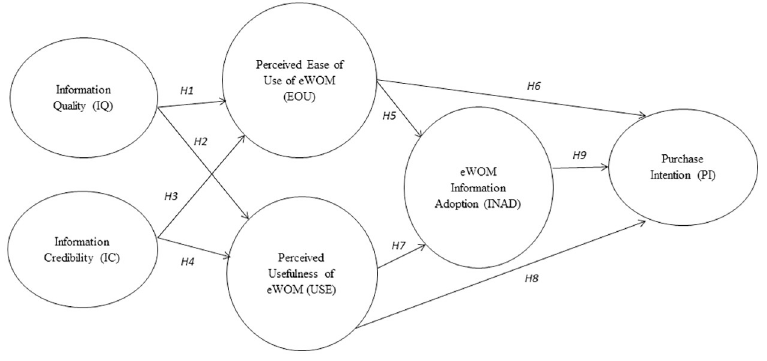
Fig 1. Conceptual model of the